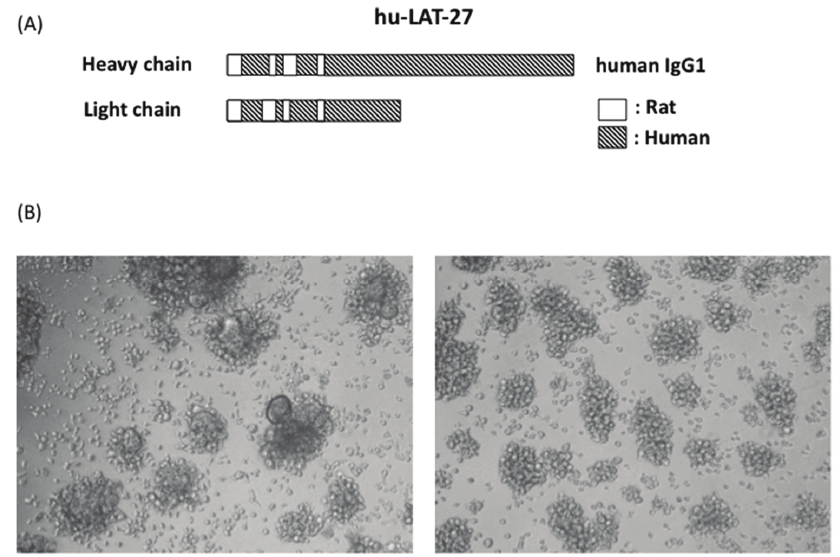
Figure 3. Schematic illustration of humanized LAT-27 and its neutralizing activity. Syncytium inhibition assay was carried out with either 200 µ g/mL of normal human IgG ( left of B ) and 5 µ g/mL of humanized LAT-27. After cultivation for 24 h, syncytium formation was microscopically observed using an inverted microscope at magnification of 100× ( right of B ).